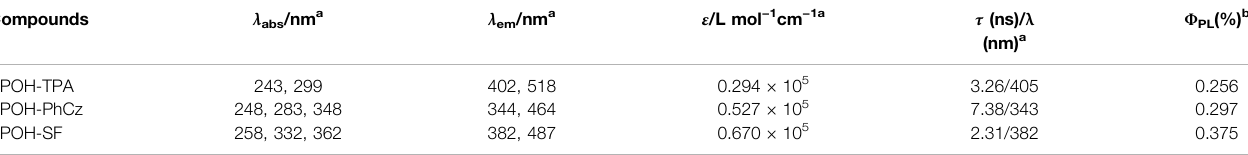
TABLE 1 | Photophysical properties of BPOH-TPA, BPOH-PhCz, and BPOH-SF in solution and solid states at room temperature. Compounds λ abs /nm a λ em /nm a τ (ns)/ λ